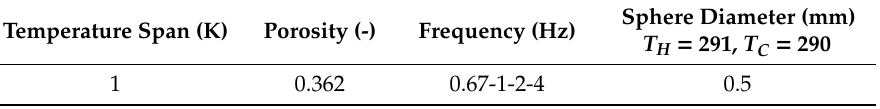
Table 4. Applied parameters to evaluate the e ff ect of the volumetric flow